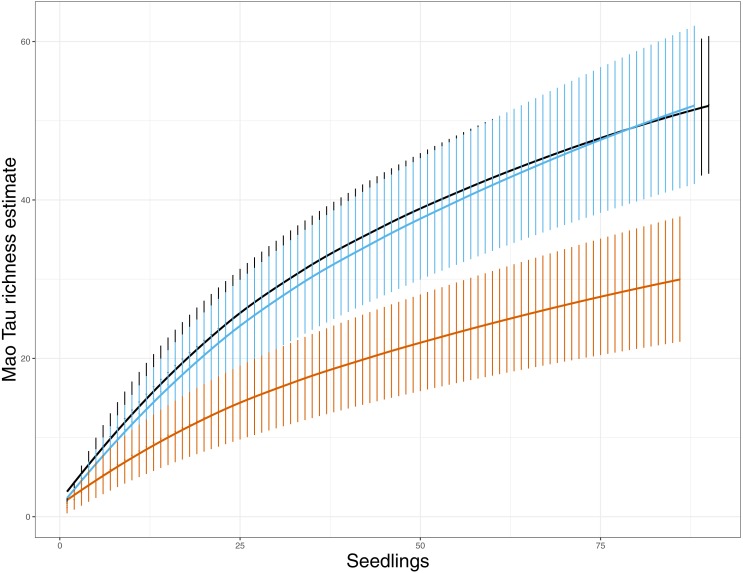
EMF species richness for both variable retention treatments and primary forest. Values are Mao Tau abundance based richness estimates with 95% CI (Colwell, Mao & Chang, 2004).Primary forest, black; aggregate retention, blue; dispersed retention, orange. The rarefaction curves indicate that richness was reduced in dispersed retention compared to aggregate retention and primary forest stands.